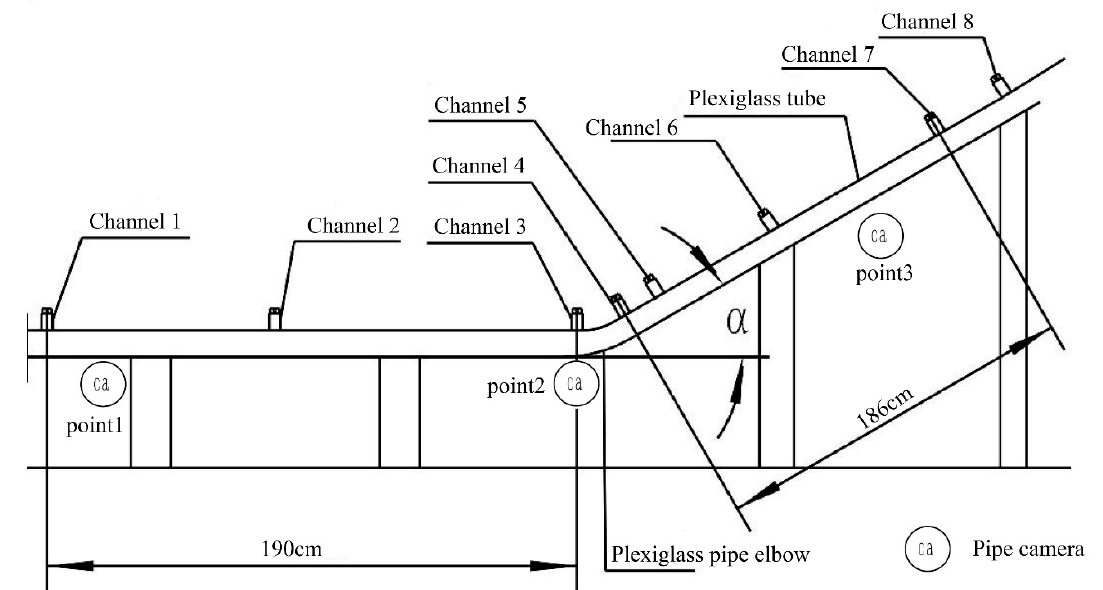
Figure 2. Schematic diagram of pipeline pressure measuring point.